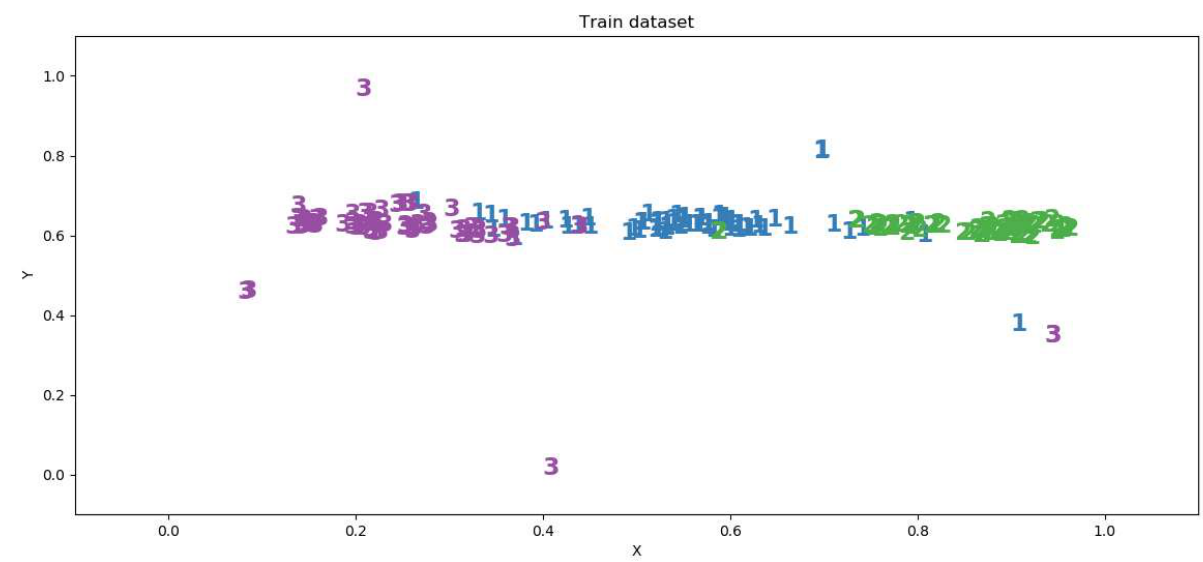
Figure 11. Wheat Seeds training dataset (different classes colored differently for convenience).